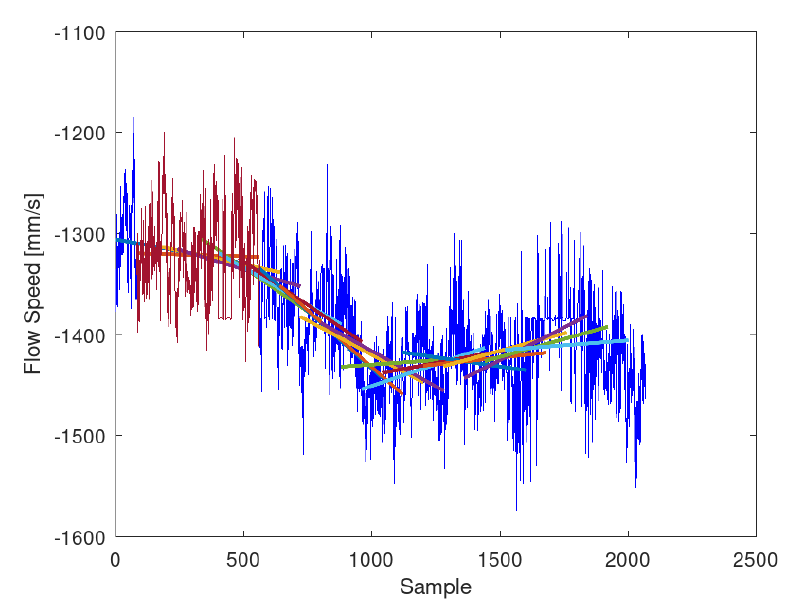
Figure A1. Example of Vector data processing. Lines indicate best fit straight lines over 30 s, slope is used as steadiness parameter. Steadiest section selected for evaluating power curve is coloured in